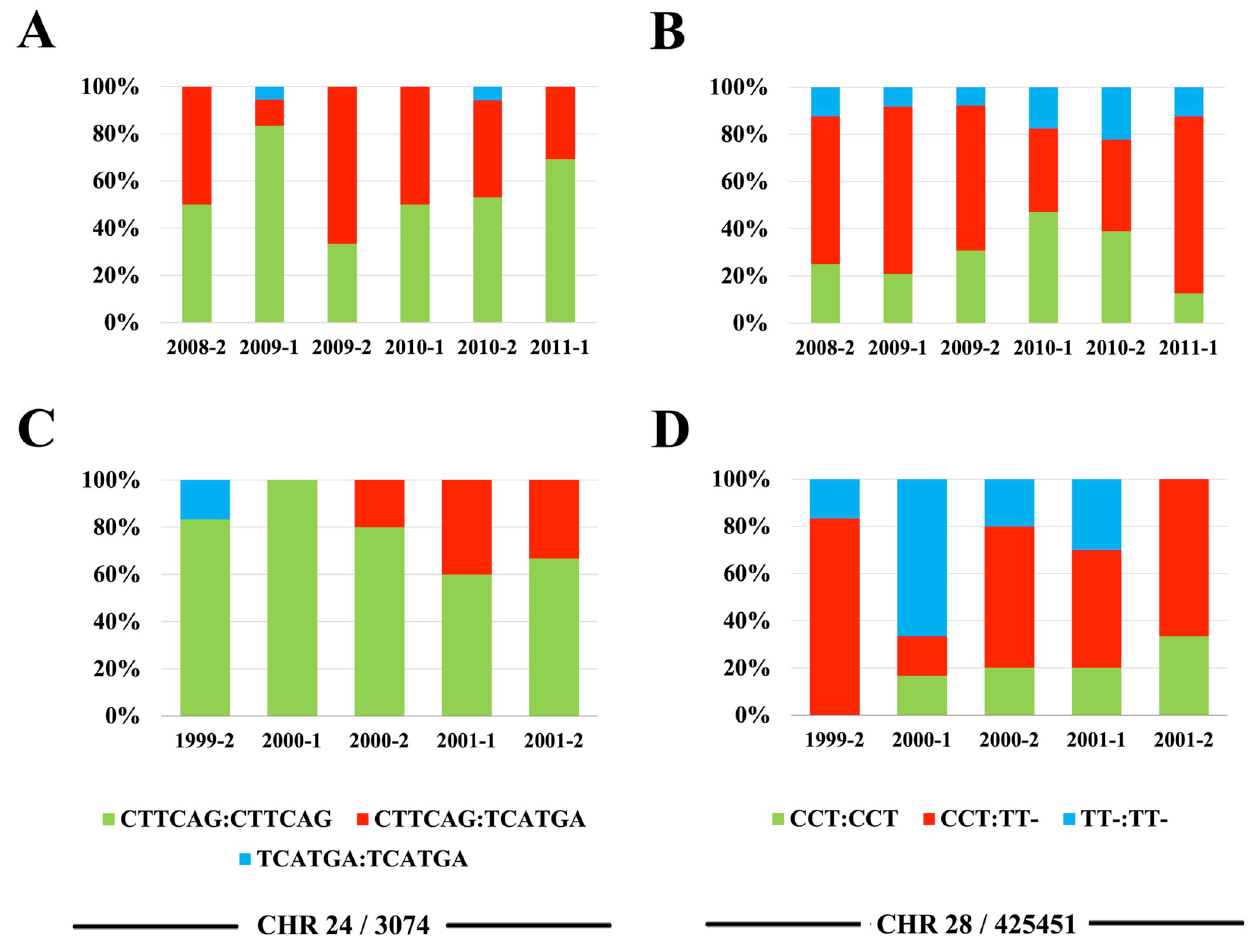
Fig 3. Time distributions of homozygous and heterozygous genotypes in CHR24/3074 and CHR28/425451. Each L . braziliensis isolate in the collection was genotyped at each locus according to their haplotype contents, considering diploid genomes. (A and C) Proportions of CTTCAG: CTTCAG (green), CTTCAG: TCATGA (red) and TCATGA: TCATGA (blue) in CHR24/3074 for the primary (A; i.e. 2008–2011) and validation (C; i.e. 1999–2001) parasite samples, respectively. (B and D) Proportions of CCT:CCT (green), CCT:TT- (red) and TT-:TT- (blue) in CHR28/425451 for the primary (B) and validation (D) samples, respectively. Overall fluctuations of genotype frequencies within each locus in each sample were not statistically significant (Chi-square p > 0.05).